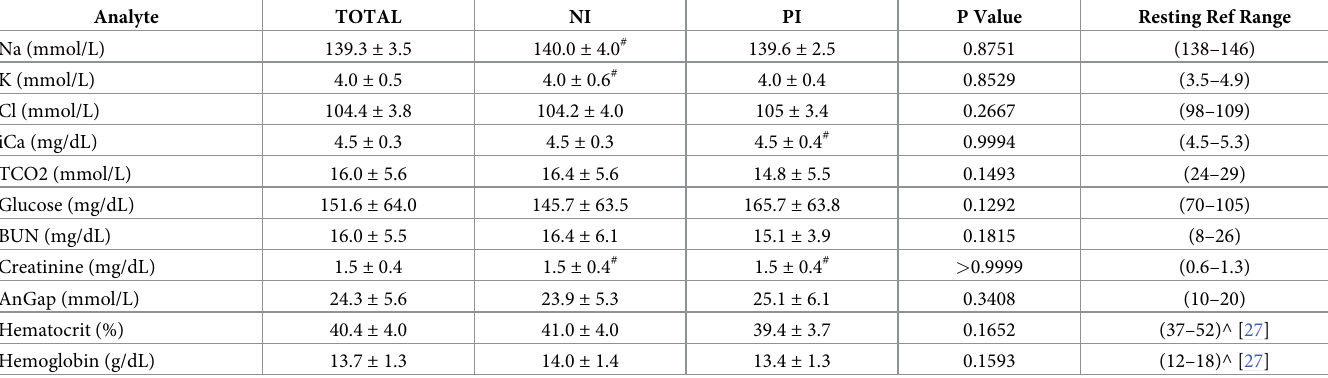
Table 2. Clinical Laboratory Values Taken at the Point of